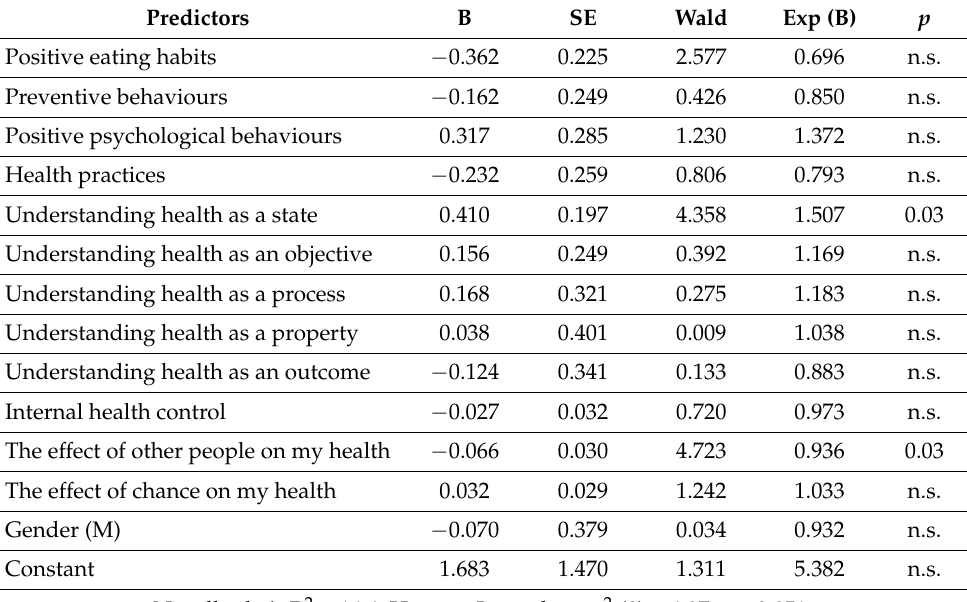
Table 2. Values of regression coefficients affecting the driving style of young adults. Predictors